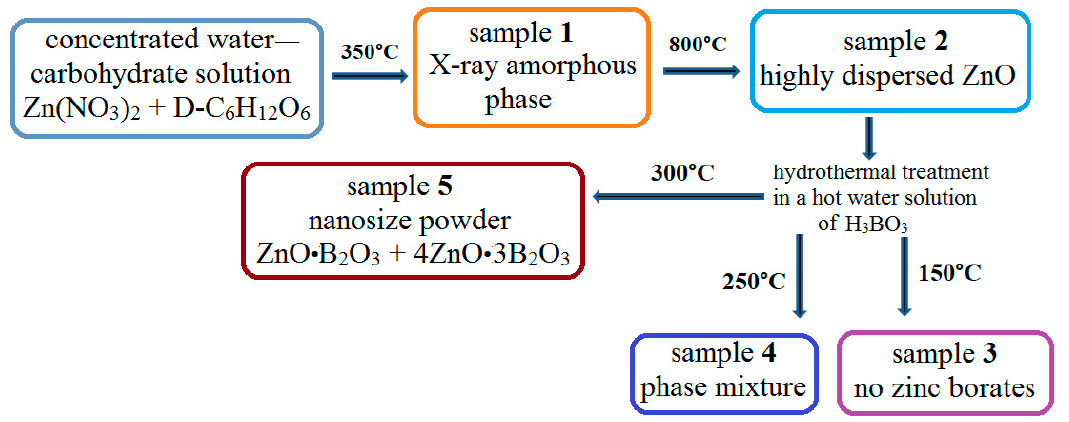
Scheme 1. General scheme of a new approach for the synthesis of anhydrous zinc borate nanopowders.